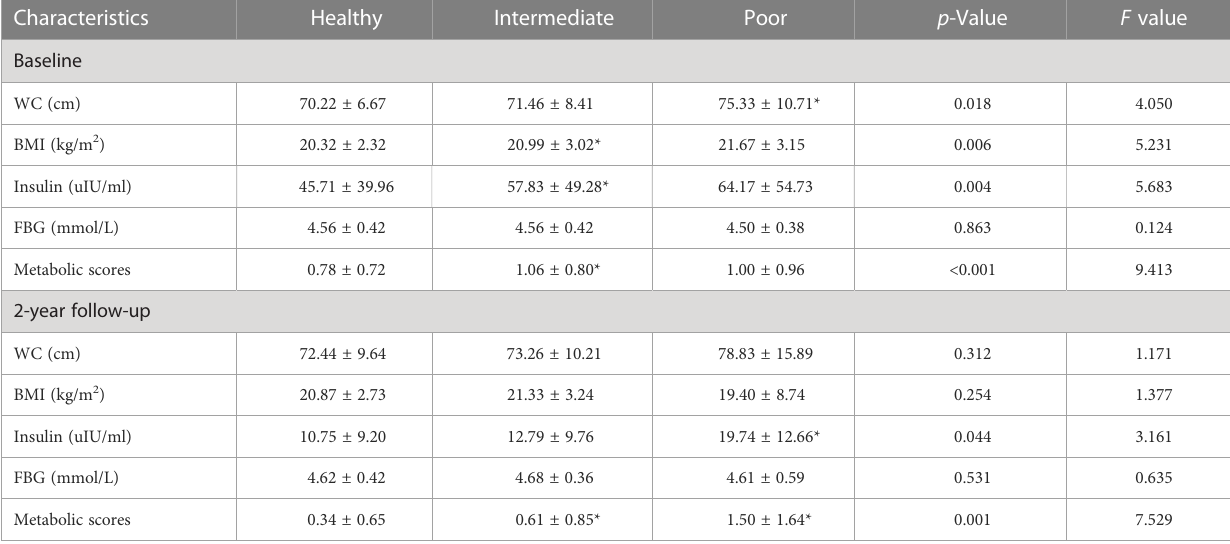
TABLE 2 Metabolic parameters according to sleep pattern.